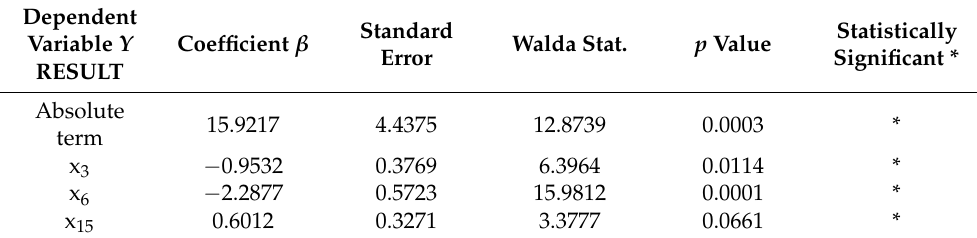
Table 5. Parameter estimates for the logit model—three explanatory